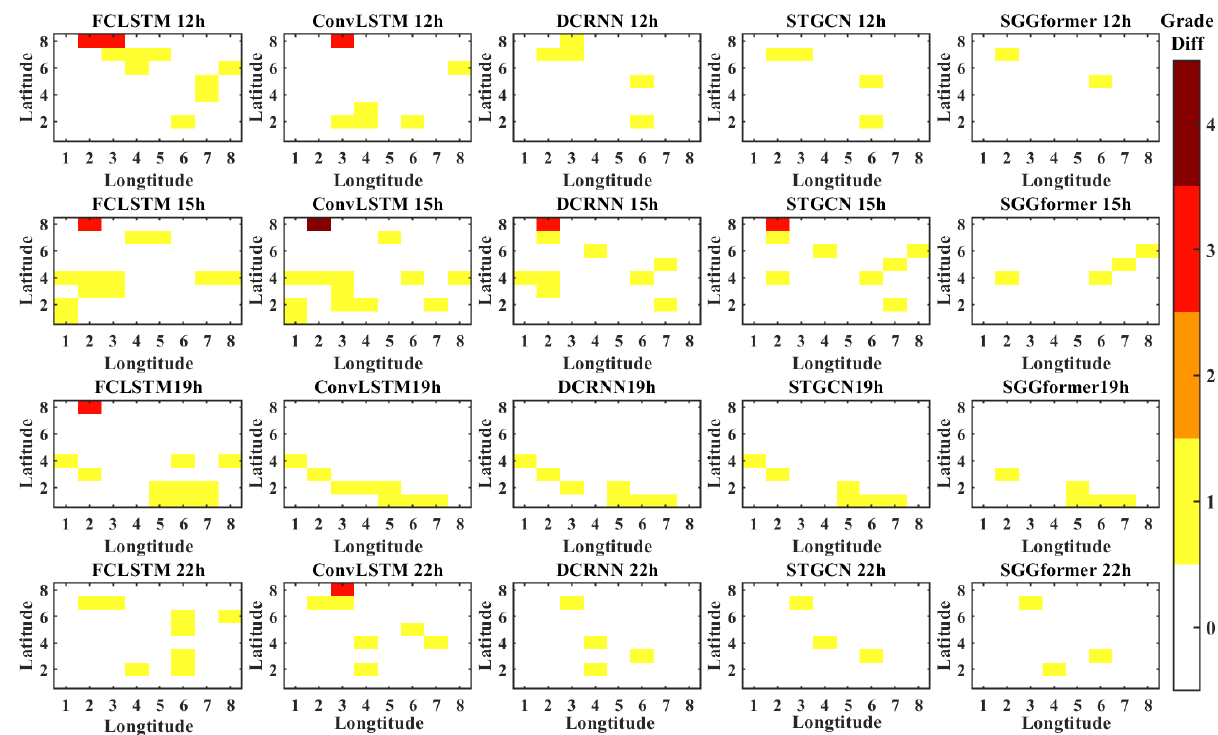
Figure 11. The grade difference under prediction length 1 h.